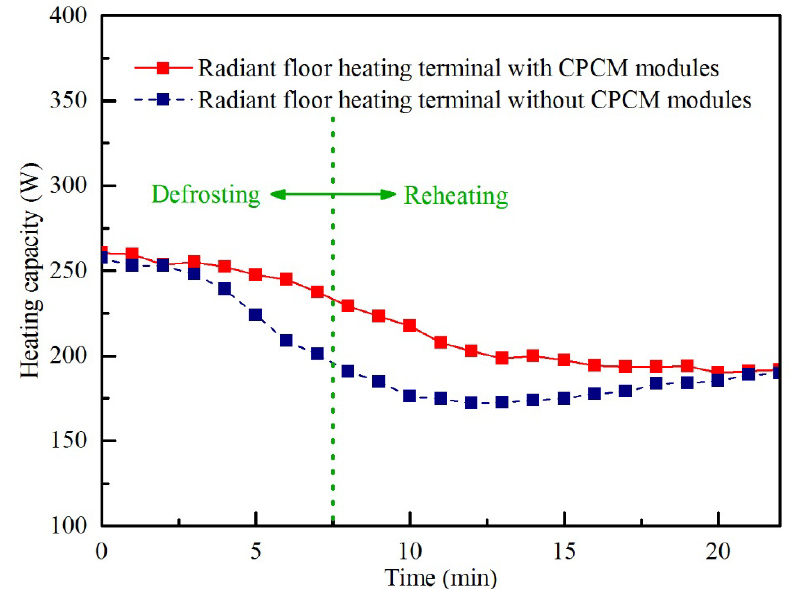
Figure 11. Heating capacity variations of radiant floor heating terminal with and without CPCM modules in defrosting condition.